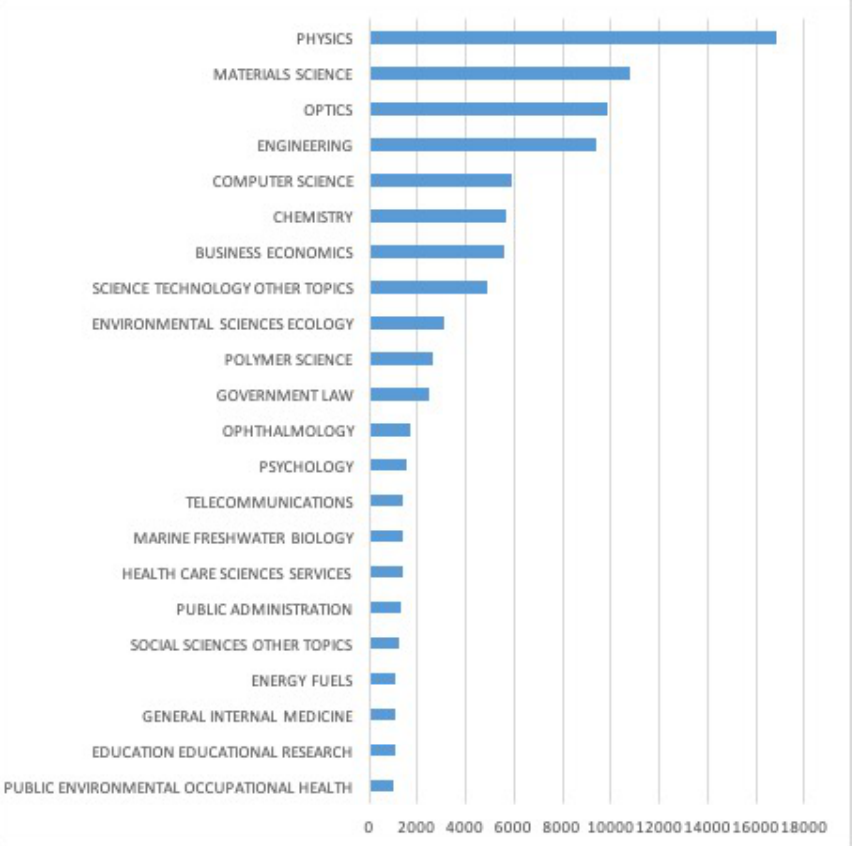
Figure 2: ‘Transparency’ use in different research areas, ›1,000 publications, based on Web of Science journal classification